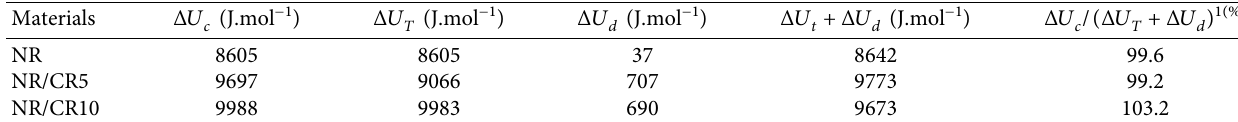
Table 8: Comparison of Δ U